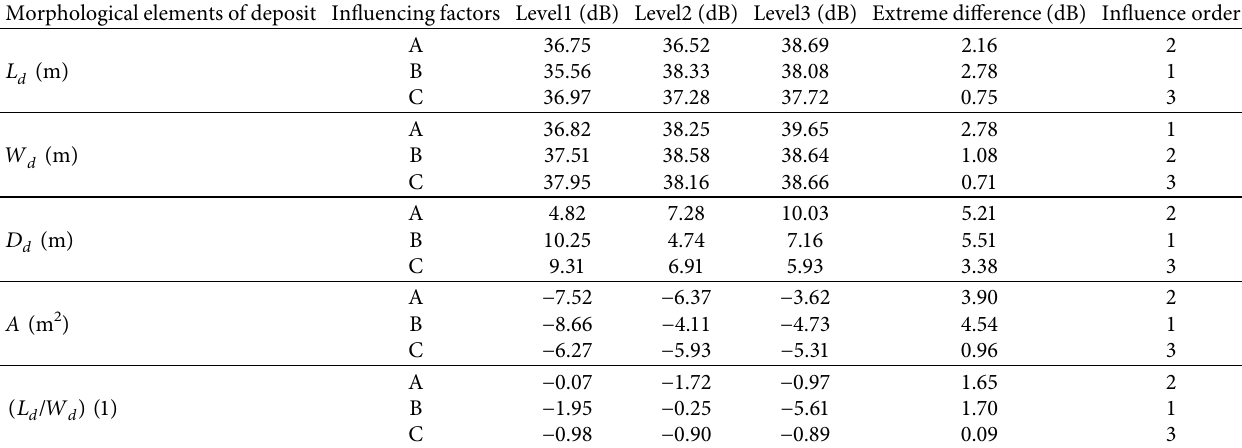
Table 4: The main factors of influence.